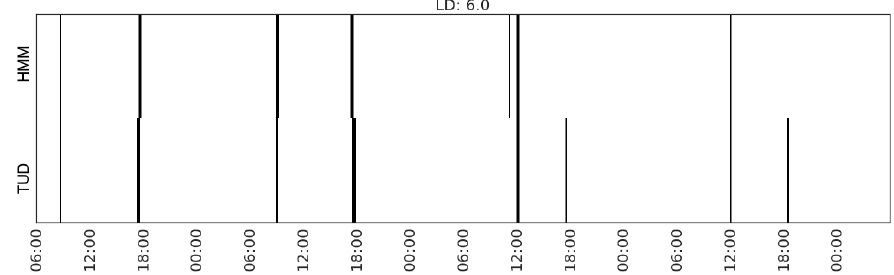
Figure 12. Recognising the activity of preparing meal in Household 1 with feature set (MS_watts_total,